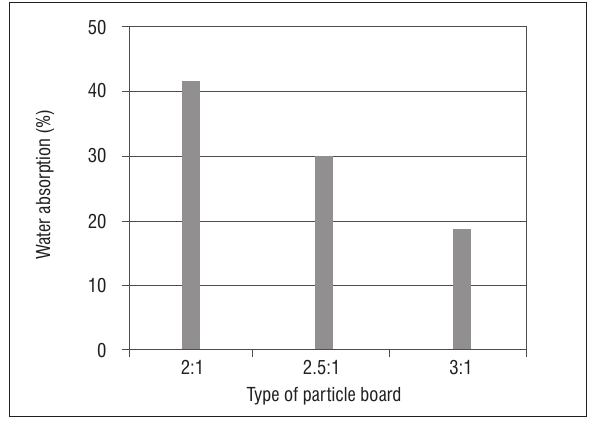
Percentage water absorption of particle board produced using different adhesive–cassava stalk ratios (2:1, 2.5:1 and 3:1).